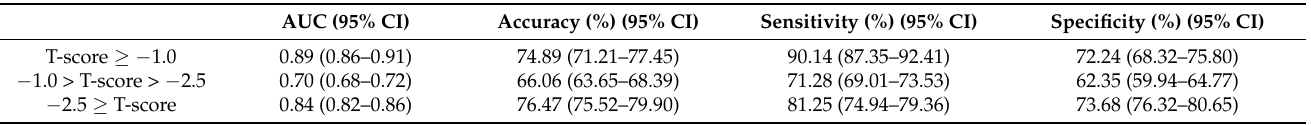
Table 2. Performance metrics of the model for the test dataset. The accuracy, sensitivity, specificity, and AUC in the respective ranges, with T-scores of − 1.0 and − 2.5 as cutoffs, are shown. AUC (95% CI) Accuracy (%) (95% CI) Sensitivity (%) (95% CI) Specificity (%) (95% CI)